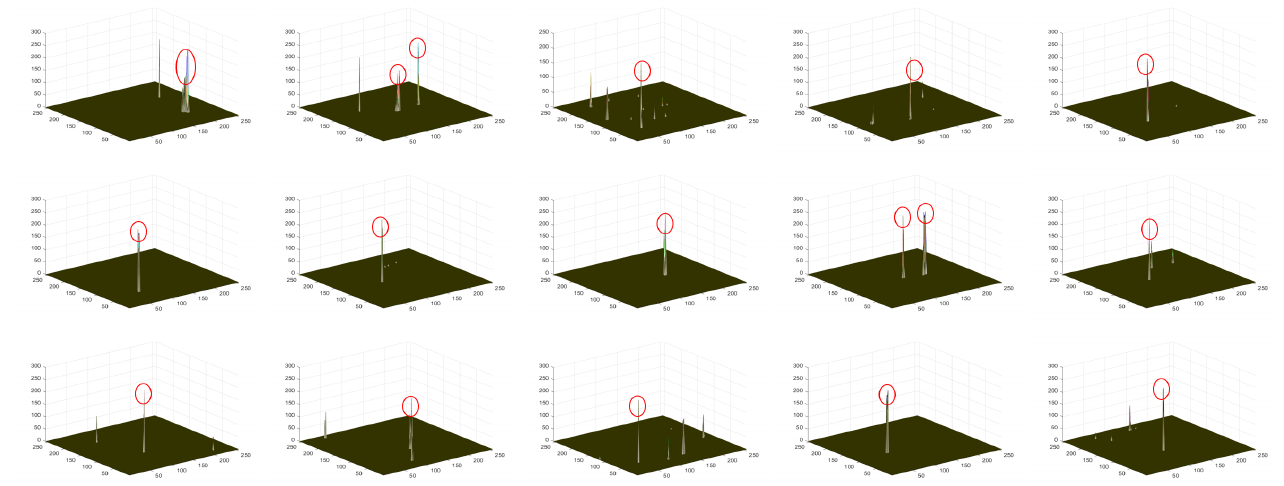
Figure 13. Three-dimensional displays of the detection results in Figure 12.